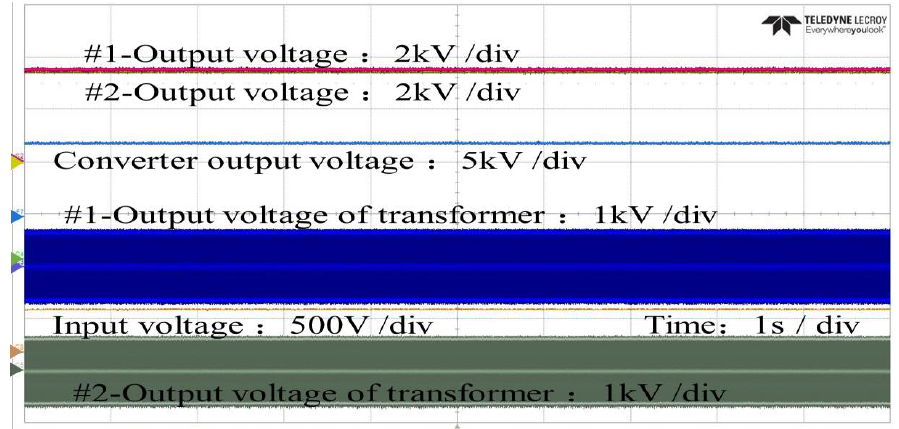
Figure 22. Steady state output voltage with current sharing control.